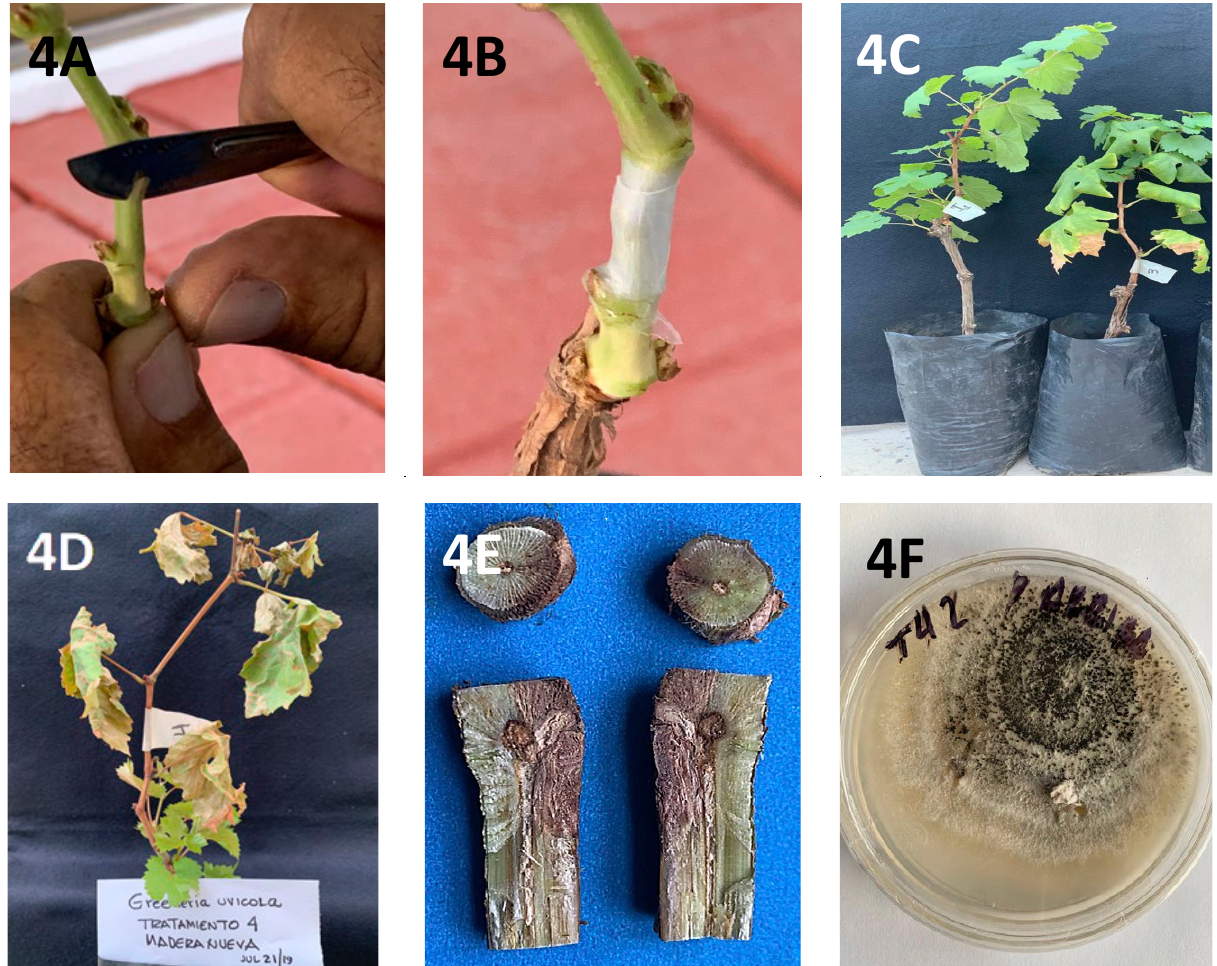
Figure 4. Pathogenicity tests. 4A and 4B; Inoculation. 4C: Healthy plants 30 d after treatment with PDA without Greeneria uvicola . 4D: Dis- eased plants after 30 d of inoculation with G . uvicola on PDA. 4E: Transverse and longitudinal cuts through stems of inoculated plants. 4F: G . uvicola re-isolated from segments of diseased plant